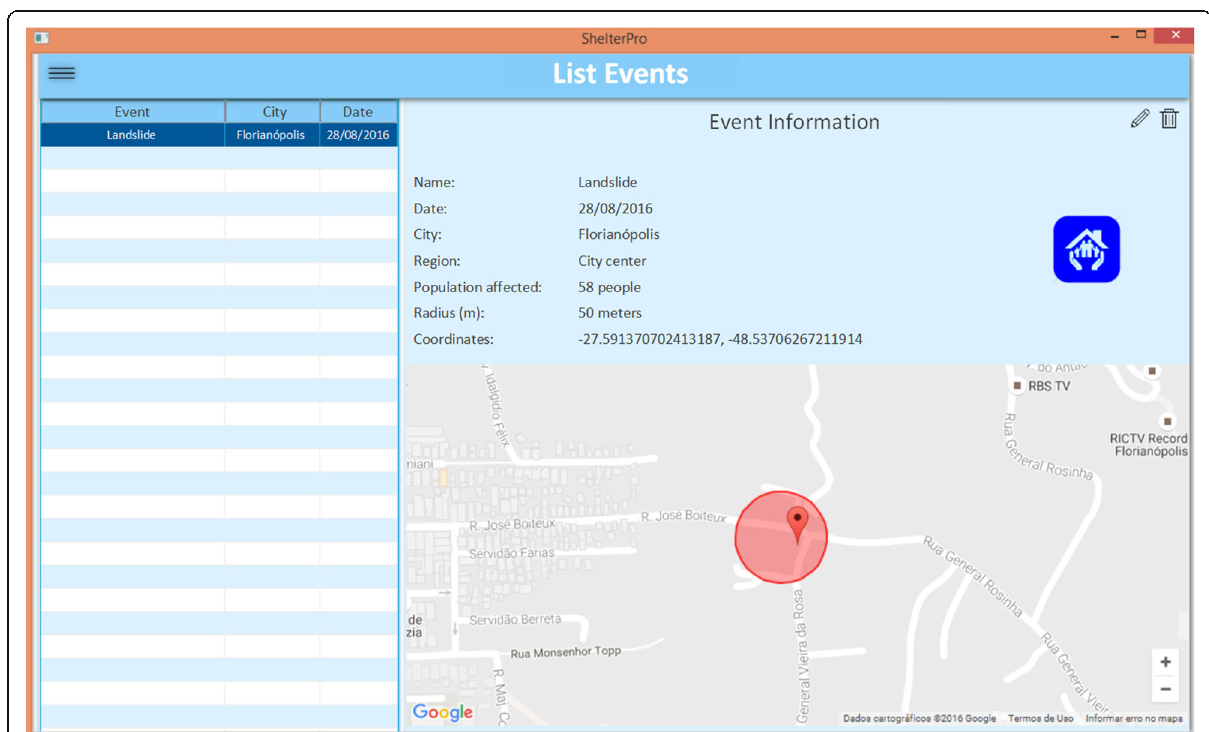
Fig. 8. ShelterPro list of events (with one event as an